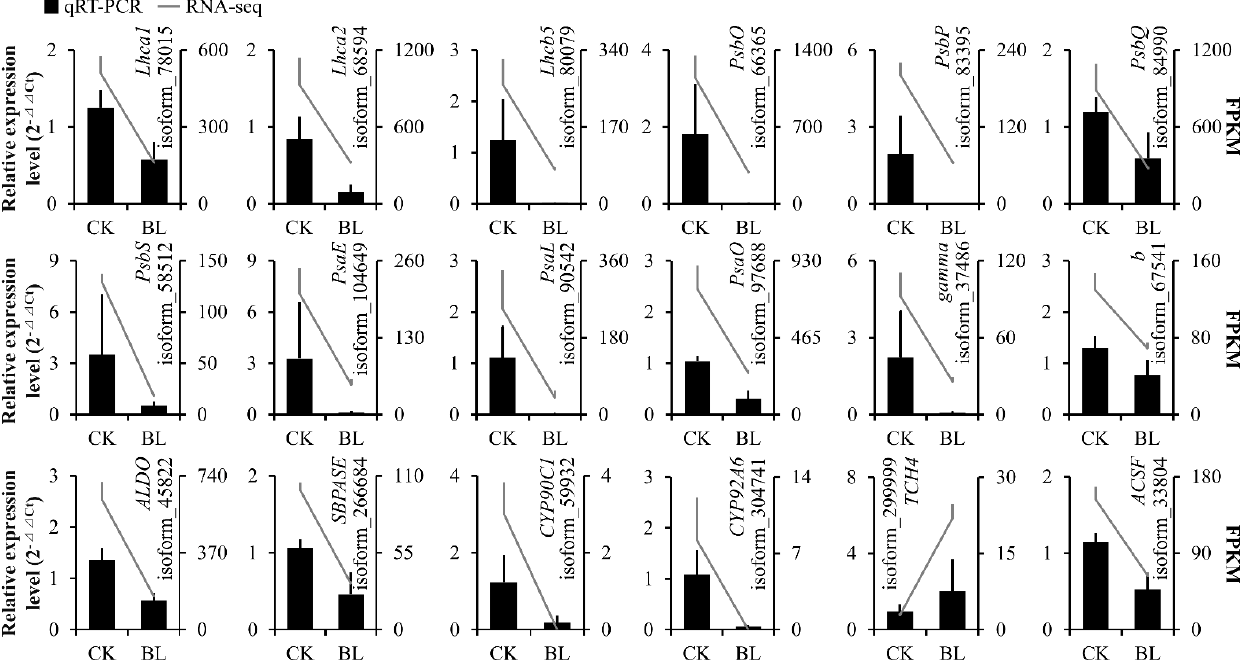
Figure 8. Quantitative real-time PCR verification. The expression trends of 18 DEGs were verified by qRT-PCR. The results of the qRT-PCR and transcriptome are shown by bar graphs and line charts, respectively.